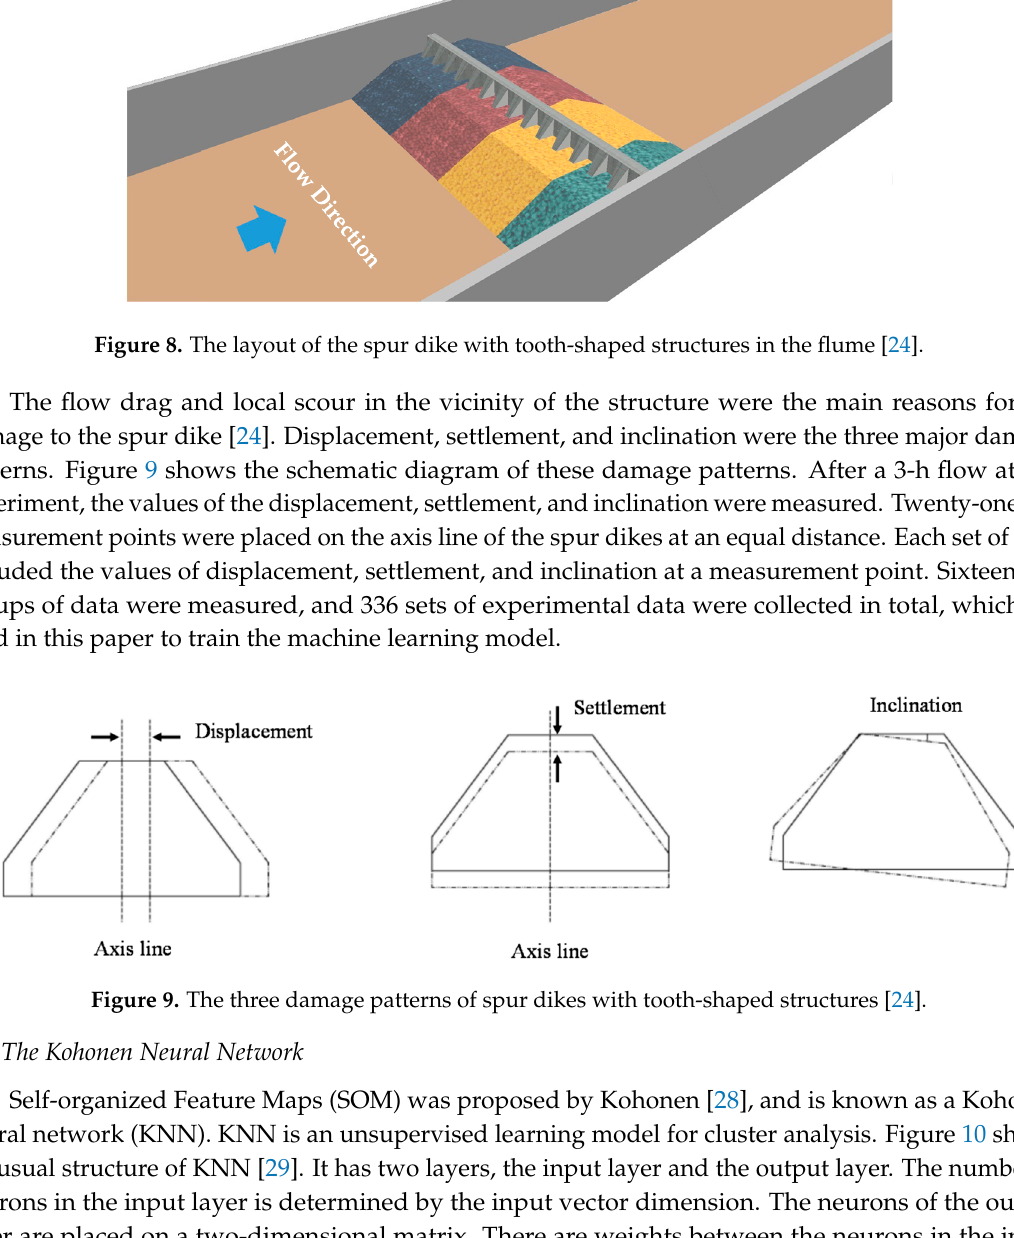
Figure 9. The three damage patterns of spur dikes with tooth-shaped structures [24].